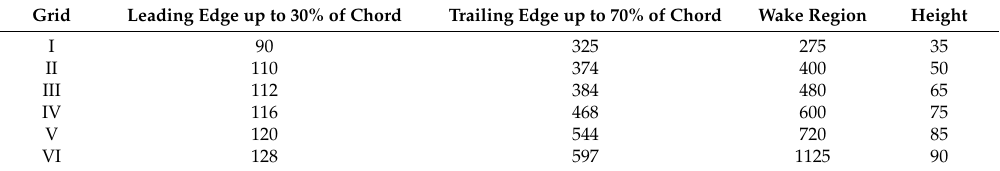
Table 2. Details of the grid cells distribution along the x -axis and y -axis.